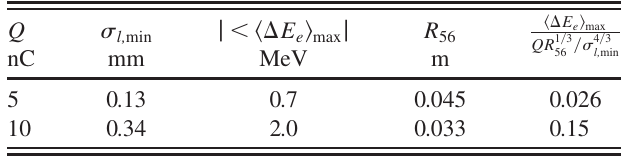
TABLE I. Self-consistency